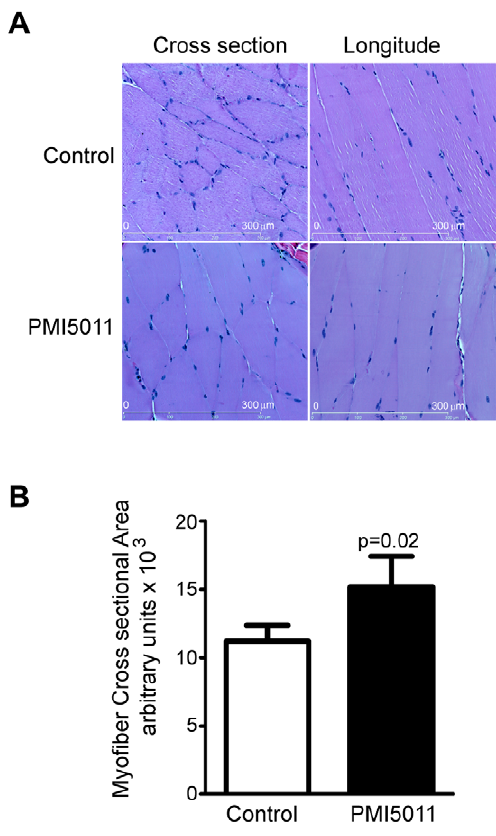
Figure 8. Skeletal muscle myofiber size is larger with dietary intake of PMI5011. (A) H&E staining of cross-section and longitudinal section of gastrocnemious skeletal muscle from control and PMI5011 supplemented KK-Ay mice. (B) The cross-sectional area of fifty myofibers/animal in each group was determined using ImageJ software. The statistical significance is reported as the mean 2 / + standard deviation, p =0.02.